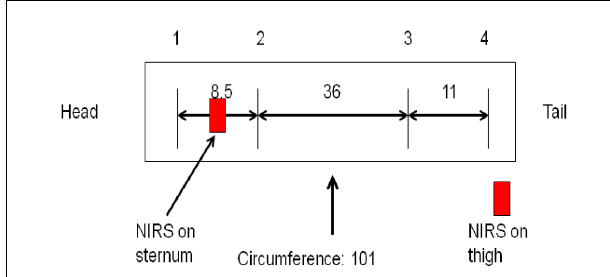
Fig. 1A: Placement of ECG electrodes for abdominal bioimpedance measurements.